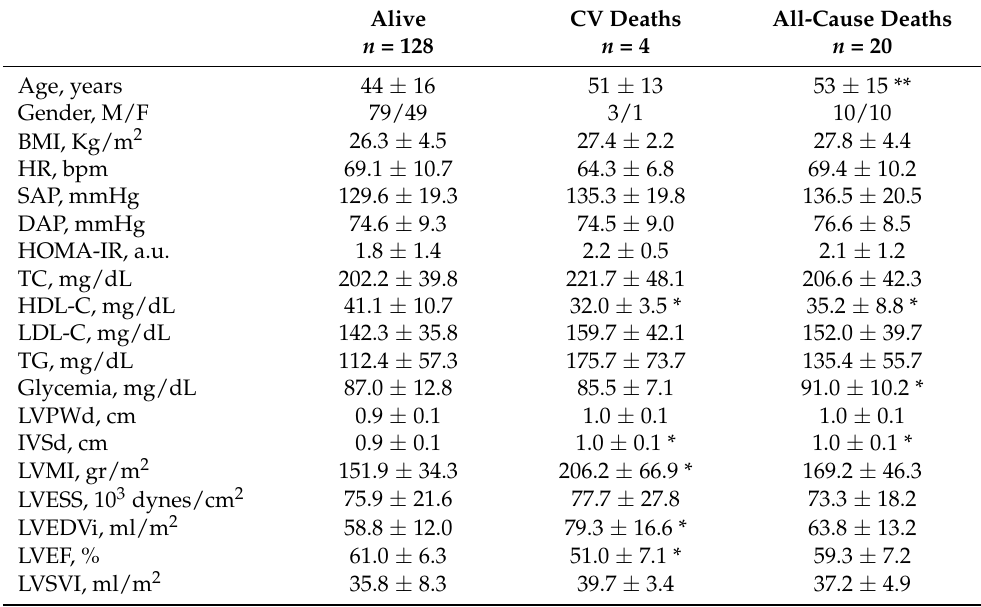
Table 5. Main clinical and echocardiographic characteristics at a 5-year